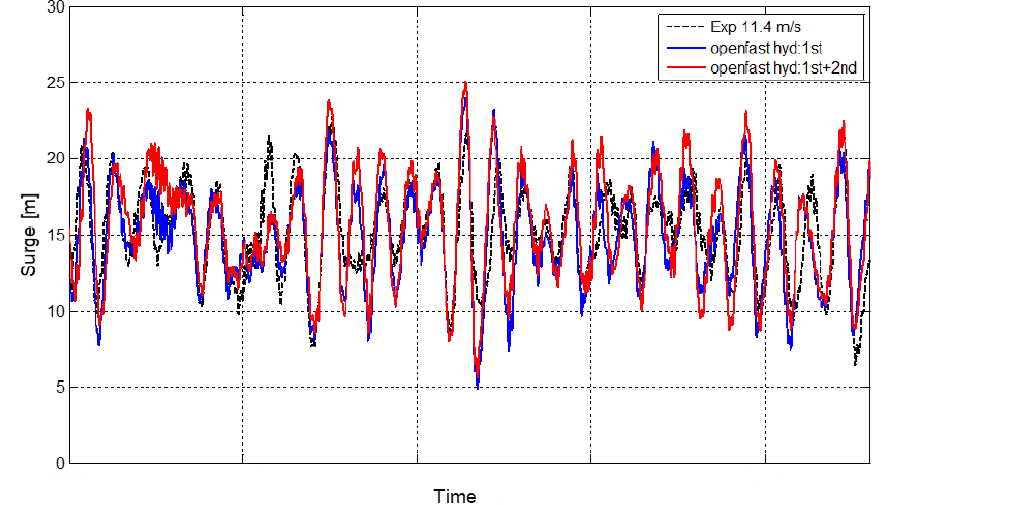
Figure 10. Time series for platform surge response under 11.4ms − 1 turbulent mean wind speed and irregular waves with H s = 3 . 0m and T p = 10 .